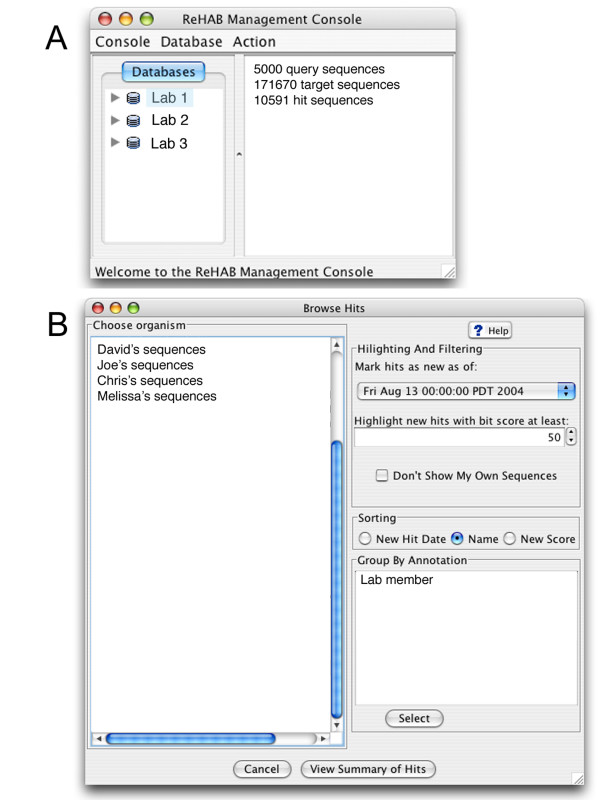
ReHAB set up for other users. A) Different laboratories in a department could have different query databases, which can be accessed as described in the text. B) The sequences within a lab's database could be annotated with individual lab member's names, or other identifying information, permitting individuals to view results for their own sequences of interest. In this way, large numbers of sequences of interest to a lab can be run simultaneously and frequently, and individuals can then browse results.